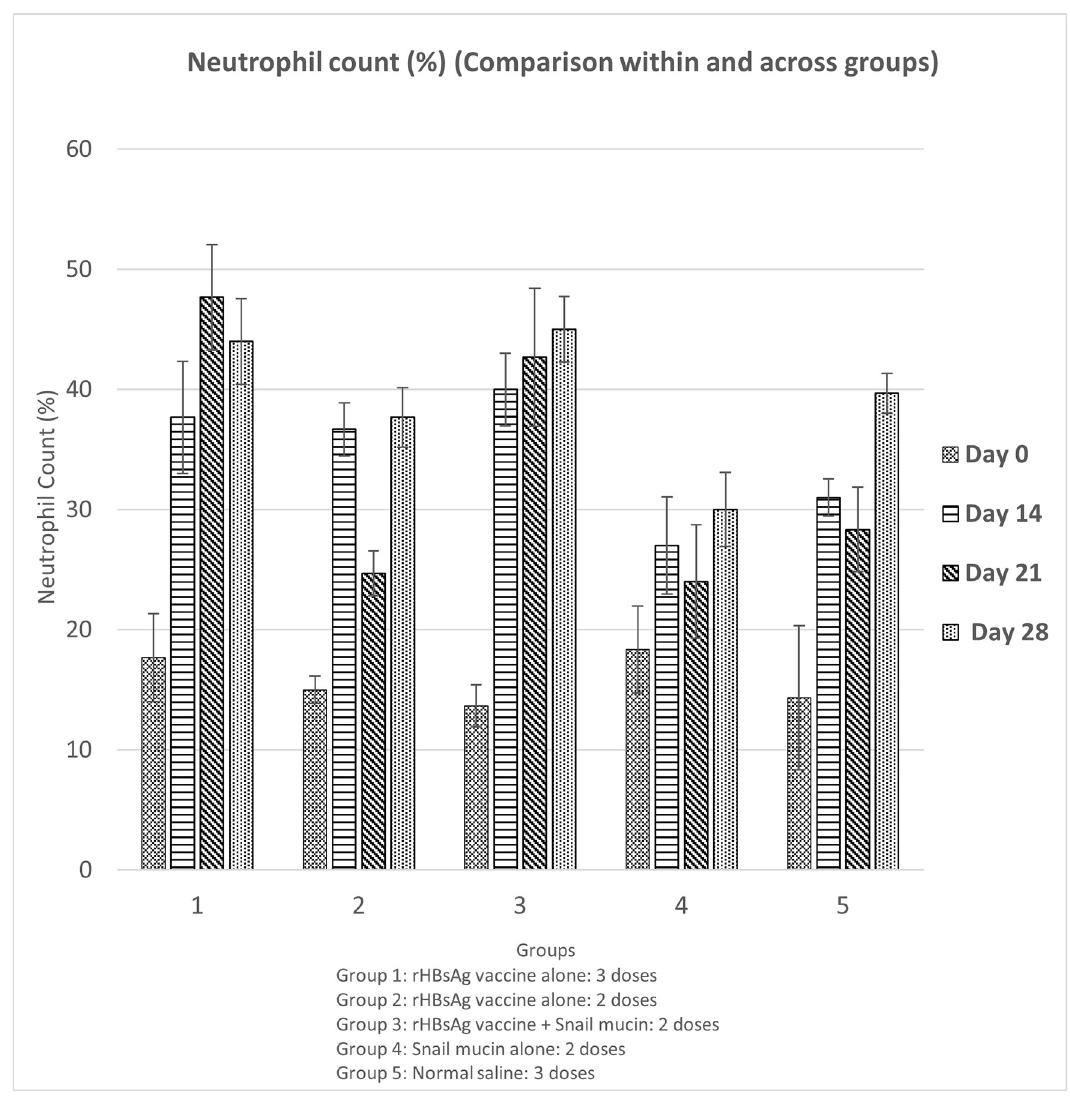
Fig 2. Effect of snail mucin-adjuvanted rHBsAg vaccine on neutrophil count of experimental mice. Results are expressed as mean ± SD (n = 5) with a confidence interval of 0.05.